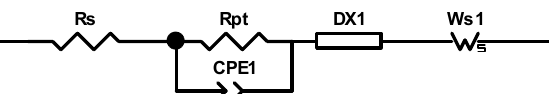
13 of 24 Figure 12. J–V curves for a set of four DSCs sensitized with [Cu( 5 )( 1 )] + with DPA as a co-adsorbent, measured on the day of sealing the cells. Figure 13. EQE spectra for a set of four DSCs sensitized with [Cu( 5 )( 1 )] + with DPA as a co-adsorbent, measured on the day of sealing the cells. 2.5. Electrochemical Impedance Spectroscopy (EIS) As discussed above, the introduction of the alkynyl spacer into the dyes results in a red-shifted absorption (Figures 3 and 6), but a blue-shifted EQE maximum (Figure 8) as well as a decrease of EQE max . The lowering of the charge transfer energy results in more difficult electron injection into the semiconductor, and the values of J SC decrease. By using electrochemical impedance spectroscopy (EIS), it is possible to investigate the multiple interfacial electronic processes in a DSC [64,65] and we therefore decided to apply EIS in an attempt to gain insight into the origin of the poorer DSC performances for dyes containing the alkynyl spacers. EIS is a technique that can describe electronic processes in terms of electron and hole diffusion in the counter electrode/electrolyte/dye-